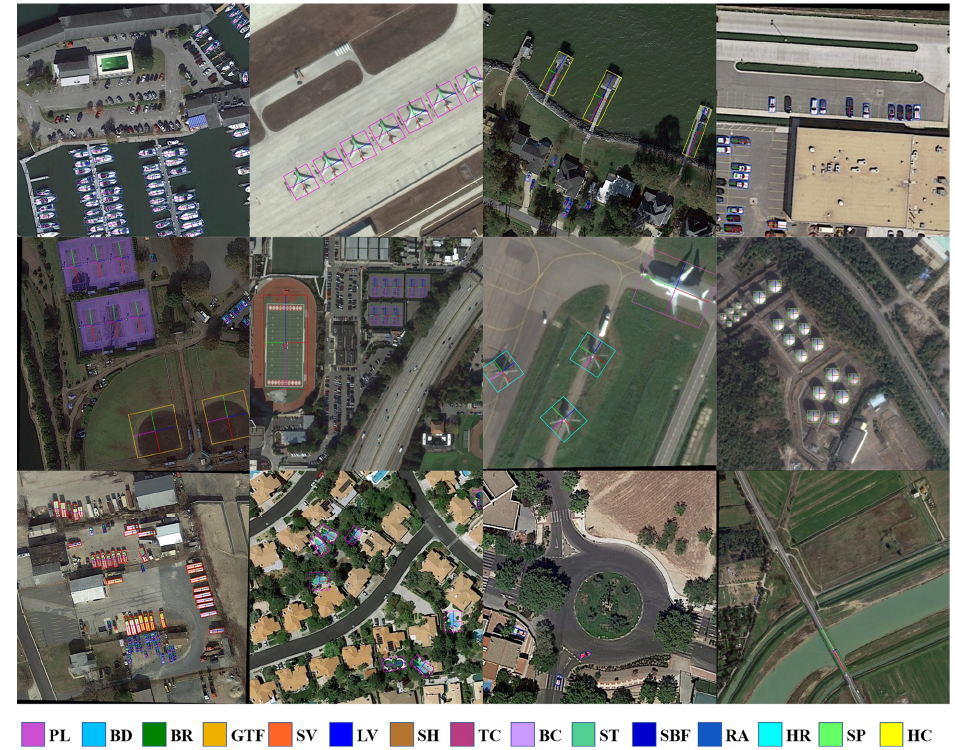
Figure 10. O 2 DFFE visualization results on the DOTA1.0 OBB task.